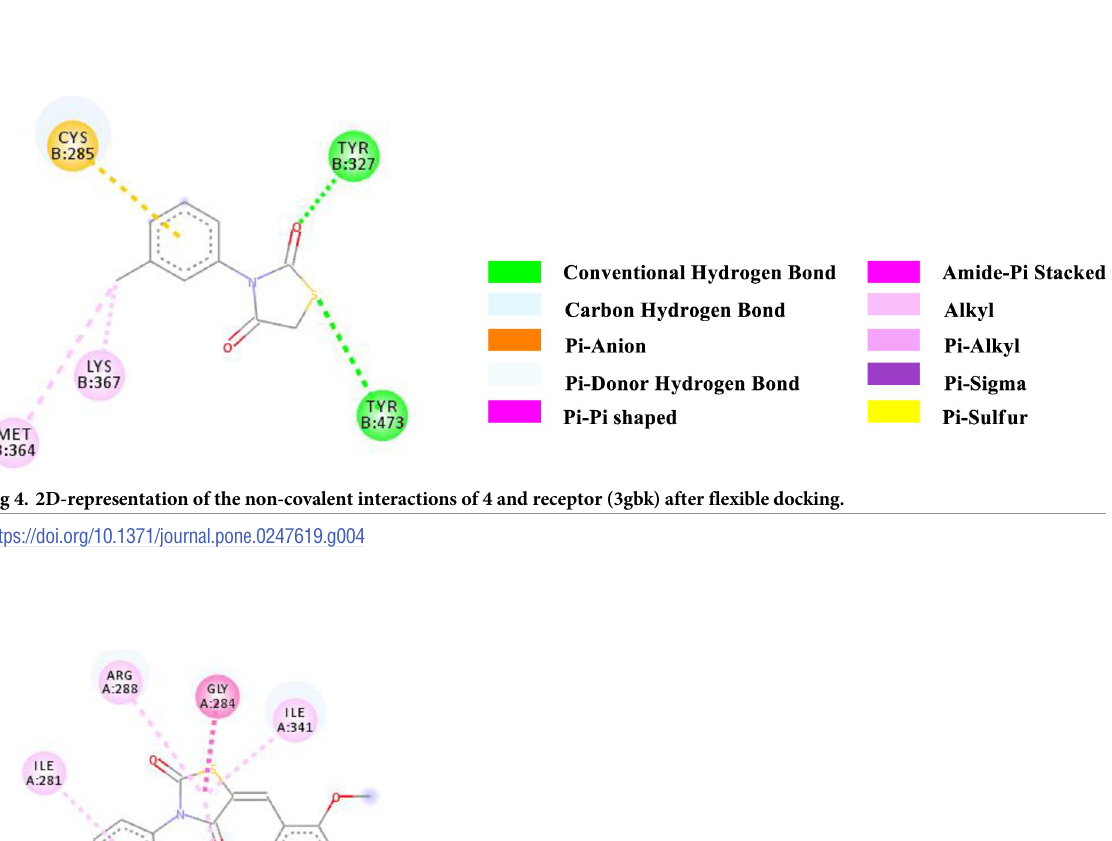
Fig 3. 2D-representation of the non-covalent interactions of Epalrestat with receptor (3gbk) after flexible docking.